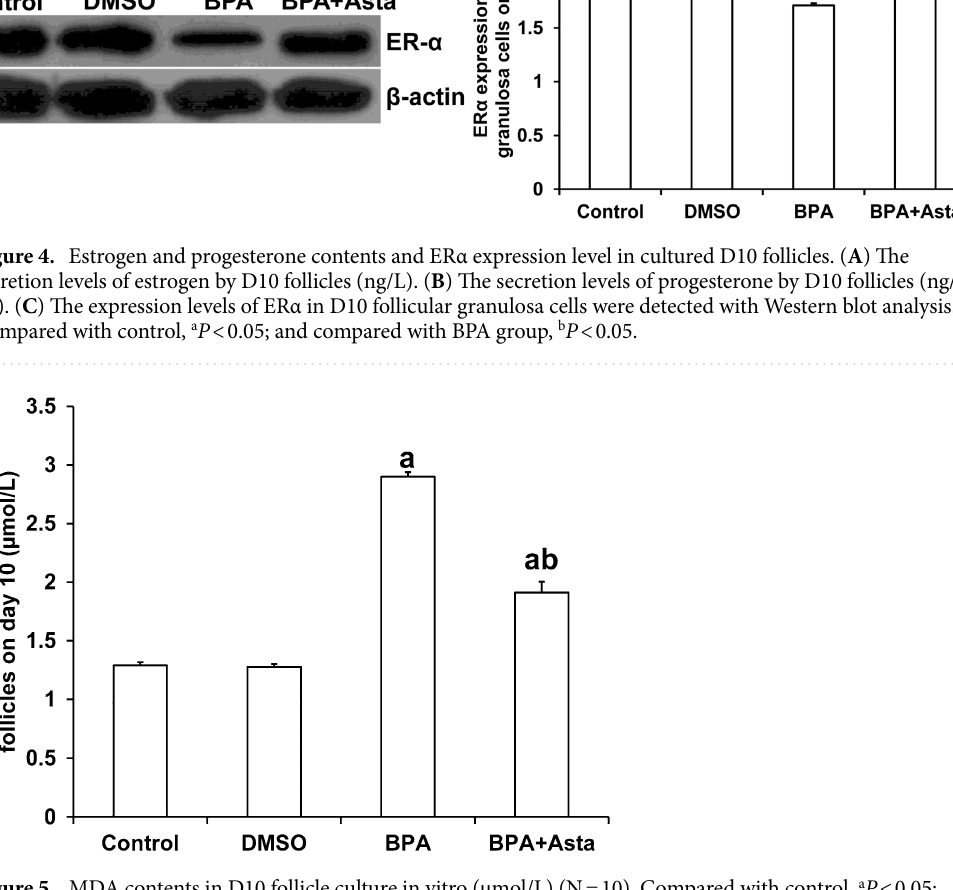
Figure 5. MDA contents in D10 follicle culture in vitro (µmol/L) (N = 10). Compared with control, a P < 0.05; and compared with BPA group, b P <